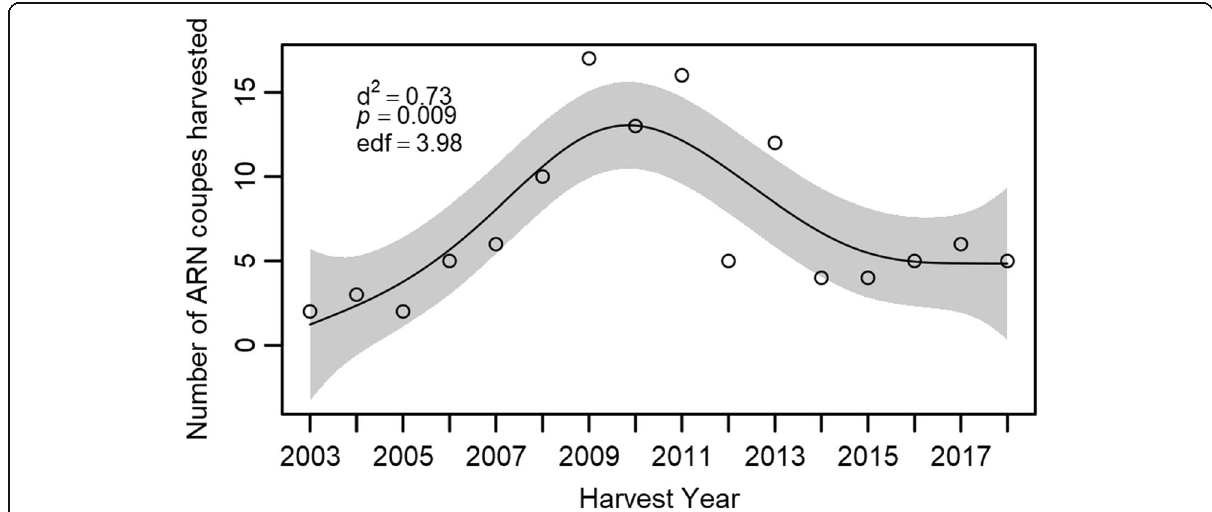
Fig. 2 Generalized additive model of the relationship between harvest year and the number of ARN coupes harvested. Shaded areas indicate the 95% confidence interval. d 2 is the proportion of the null deviance explained by the model. p values indicate the approximate significance of the single smooth term, while edf is the estimated degrees of freedom for the smooth